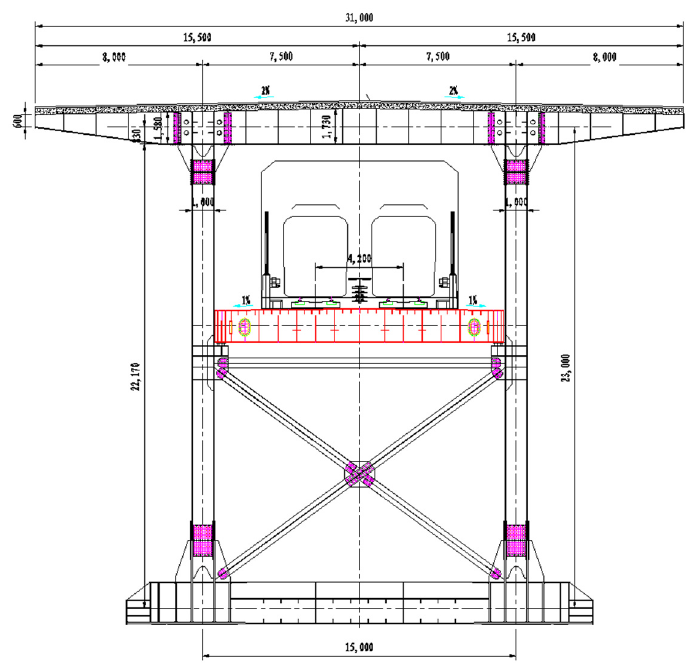
Figure 4. Cross section at bearing (Unit: mm).